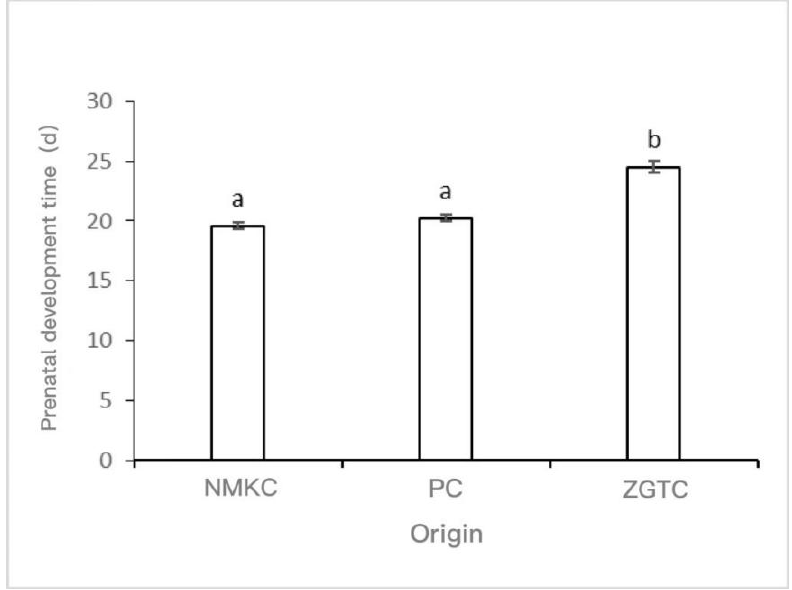
Figure 5. Prenatal development time of Daphniopsis tibetana from different origins. Means with different lowercase letters are significantly different ( p < 0.05). a: no significant difference; b: significant